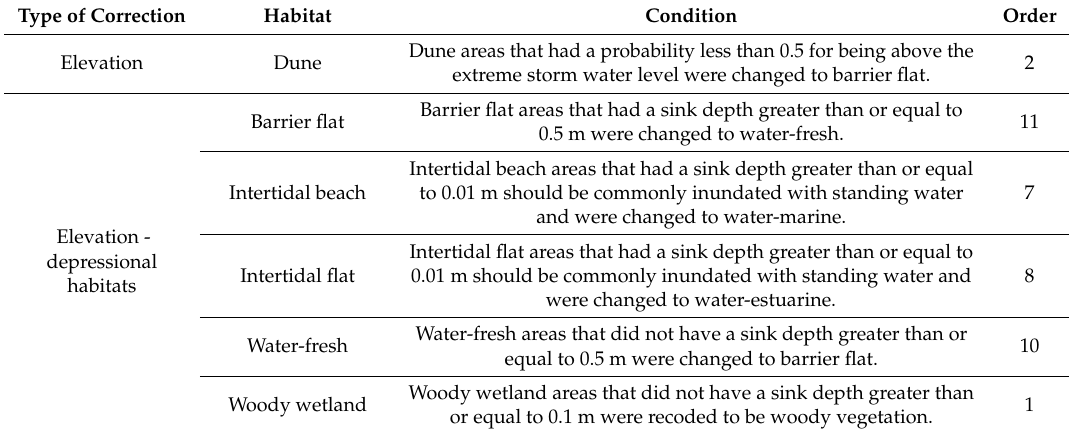
extreme storm water level were changed to barrier flat.